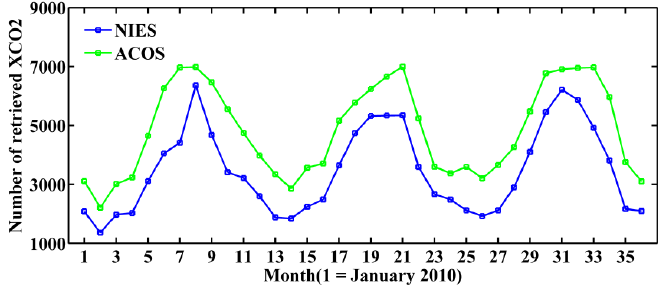
Figure 3. The monthly number time series of global retrieved NIES and ACOS XCO 2 passing the post-screening filters. The data is limited to High gain land surface.